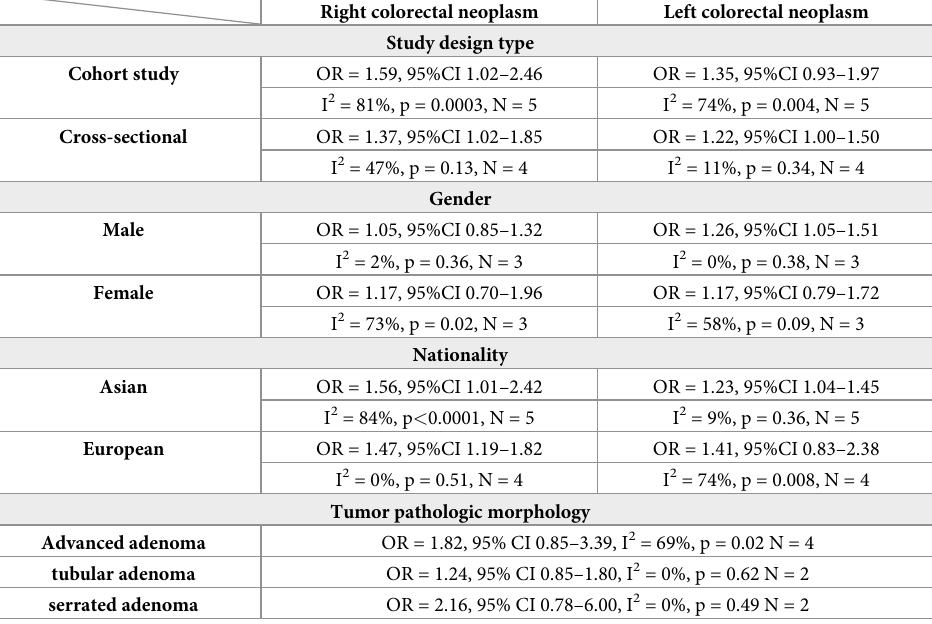
(Asian & Right: OR = 1.56, 95% CI 1.01–2.42, I 2 = 84%, P < 0.0001) was obviously higher in Asians with NAFLD than left tumors (Asian & Left: OR = 1.23, 95% CI 1.04–1.45, I 2 = 9%, P = 0.36), but the risk relevance was similar and moderately associated with an increased risk of incident double-sided colorectal tumors in Europeans (European & Right: OR = 1.47, 95% CI 1.19–1.82, I 2 = 0%, P = 0.51; European & Left: OR = 1.41, 95% CI 0.83–2.38, I 2 = 74%,